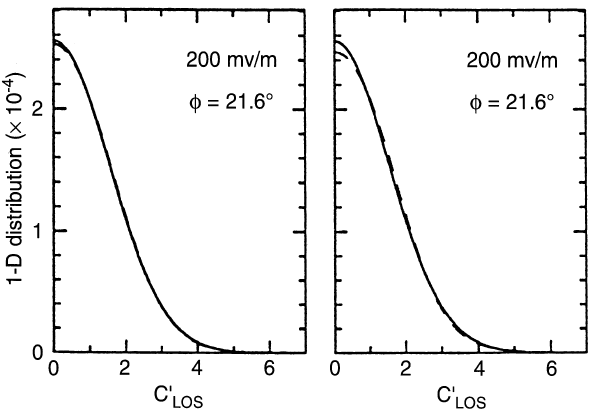
Fig. 3. Maxwellian expansion of the 1-D distribution for an electric field of 200 mV/m, and an angle-of-sight of 21 : 6 (cid:14) . The corresponding Maxwellian is marked by a solid line , the third order expansion is a dotted line in the left panel , and the fourth order expansion is a dashed line in the right